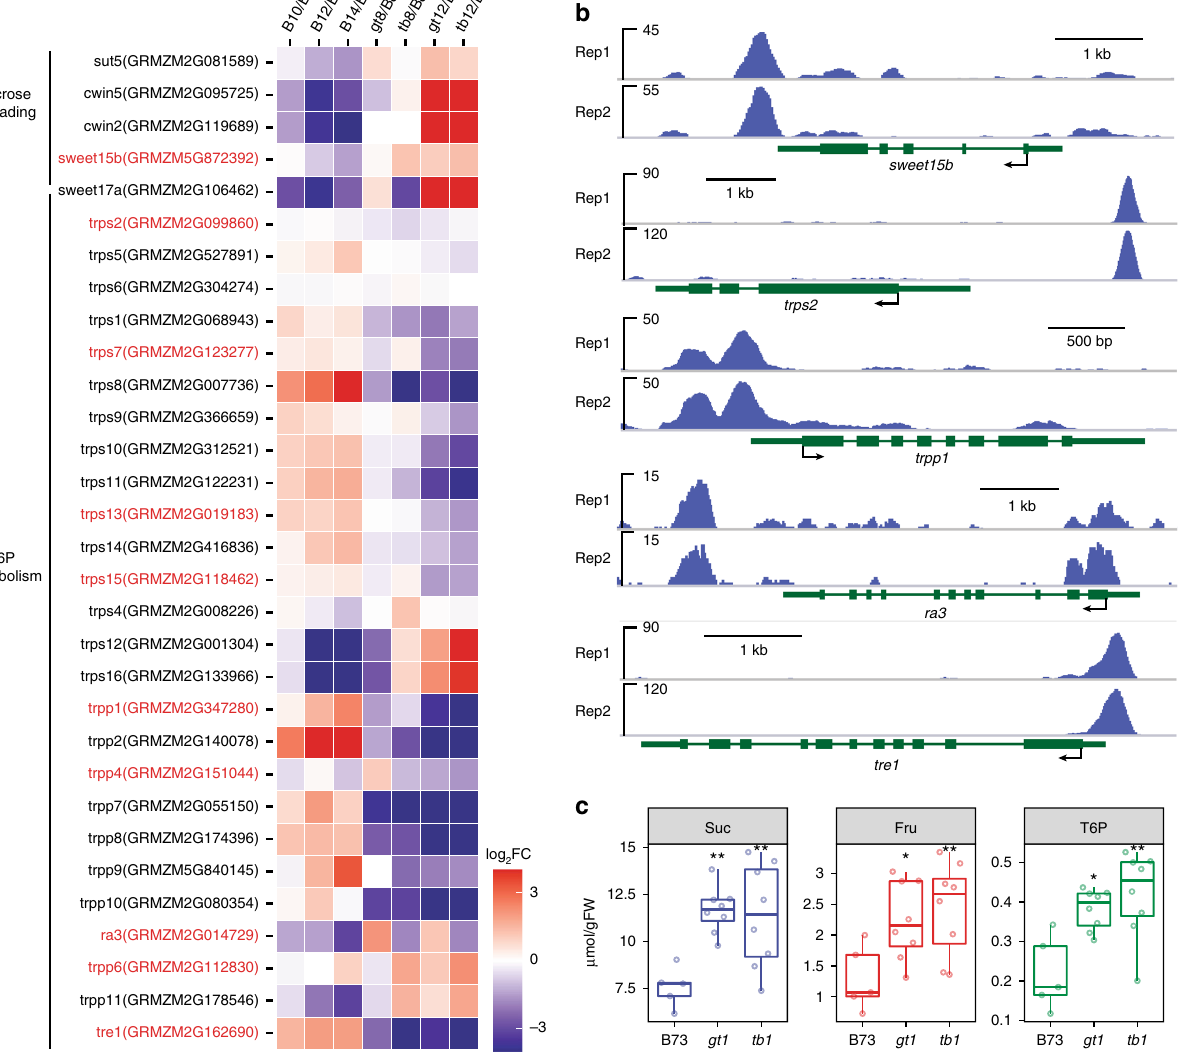
Fig. 4 Bud dormancy is associated with tb1 - gt1- mediated regulation of sugar signaling and energy homeostasis. a Genes involved in sucrose unloading and T6P metabolism were differentially expressed in tiller buds across B73 developmental series, as well as in tb1 and gt1 (bud stages and genotypes labeled as described in Fig. 3). Gene names highlighted in red were also bound by TB1 by ChIP-seq. FC fold change. Gradient color scale indicates the log value of expression fold change (log 2 FC). b TB1 ChIP-seq-binding peaks near several differentially expressed sugar signaling genes in a . rep1 and rep2 represent two biological replicates of the TB1 ChIP-seq assay. c Quanti fi cation of sucrose (Suc), fructose (Fru), and trehalose-6-phosphate (T6P) levels in tiller buds of B73, gt1 , and tb1 at 12 DAP. Plots show means ± SE calculated from at least fi ve biological replicates. * p < 0.05, ** p < 0.01; two-tailed Student ’ s t